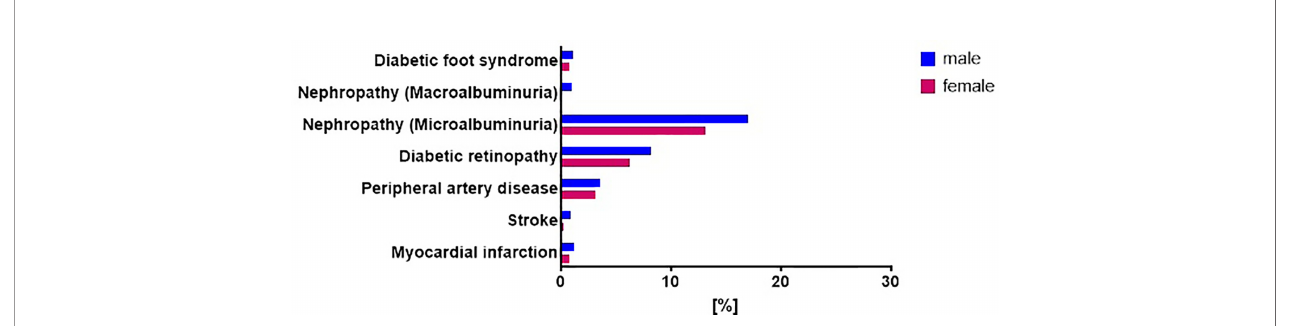
FIGURE 7 | Prevalence of diabetes related complications in patients with newly diagnosed type 1 diabetes strati fi ed by sex. Prevalence of diabetes-related complications in males (blue) and females (red) with newly diagnosed type 1 diabetes from the GDS and DPV cohort. Data was collected on the prevalence of diabetic foot syndrome, diabetic nephropathy (micro- or macroalbuminuria), diabetic retinopathy, peripheral artery disease, myocardial infarction and stroke. Data are expressed as percent from the total number of measured participants in each cohort. P values refer to data adjusted for age, sex, BMI, migration background, hypertension and dyslipidemia.*p <